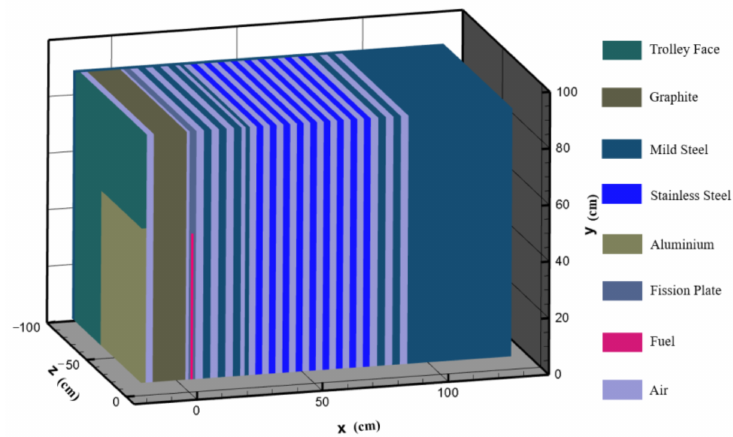
Figure 13. Computational model of the JANUS Phase I